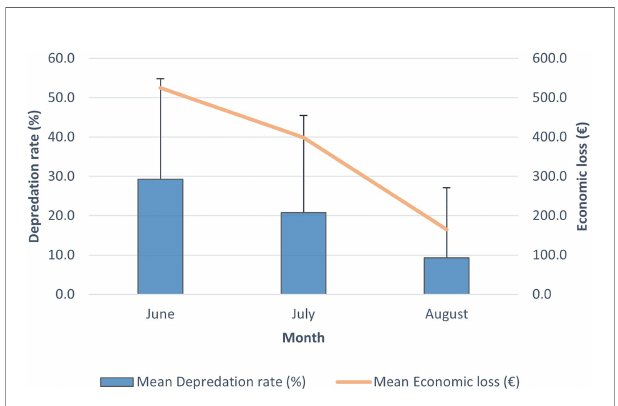
FIGURE 5 | Mean depredation rate (%) and mean economic loss ( € ) for each of the three fi shing months in 2018. Error bars indicate standard deviation.